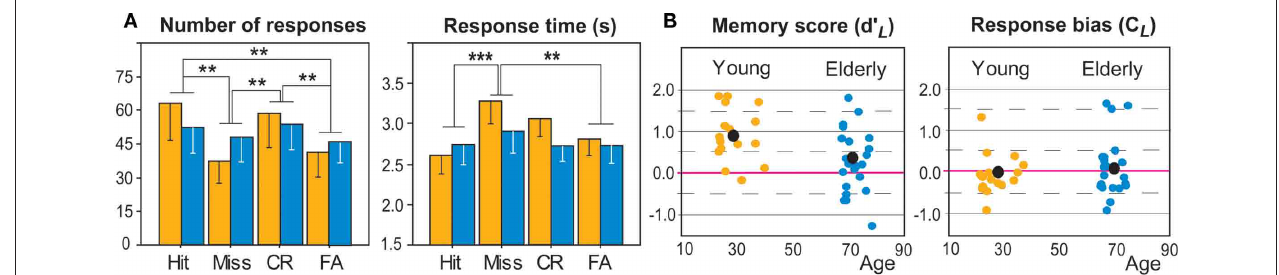
FIguRe 2 | Behavioral data in young (orange) and elderly (dark blue) subjects. (A) Number of responses (in percent of Hit and Miss relative to the number of old items and percent of FA and CR relative to the number of new items), and Responses times, as a function of four response categories. (B) Memory scores ( d ′ and response bias scores ( C ). Black dot, mean value; red line, zero value; * p < 0.05; ** p < 0.01; *** p L